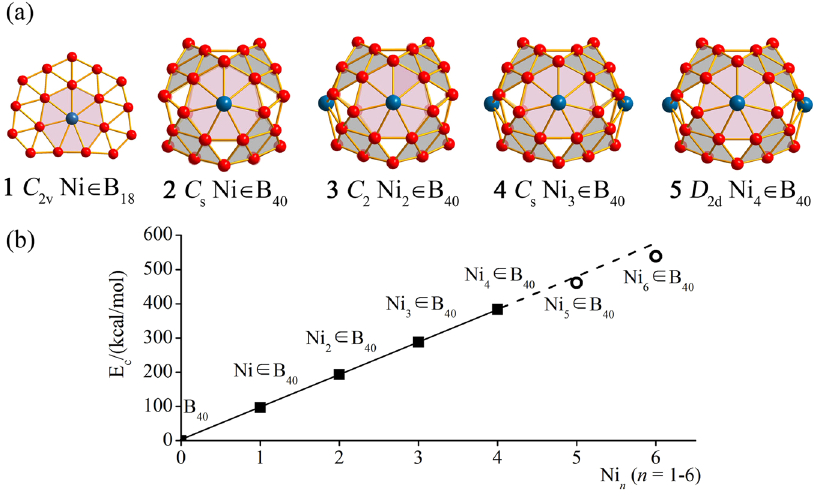
Figure 1. Optimized structures and calculated coordination energies. ( a ) Optimized structures of perfectly planar C 2v Ni ∈ B 18 ( 1 ) and cage-like C s Ni ∈ B 40 ( 2 ), C 2 Ni 2 ∈ B 18 ( 3 ), C s Ni 3 ∈ B 40 ( 4 ), and D 2d Ni 4 ∈ B 40 ( 5 ) at PBE0/6-311 + G * level. ( b ) Calculated coordination energies (E c ) of the Ni n ∈ B 40 heteroborospherenes with respect to Ni n B 40 = Ni (n-1) B 40 + Ni (n = 1–6).The optimized structures of the C 2v Ni 5 ∈ B 40 ( 8 ) and D 2d Ni 6 ∈ B 40 ( 9 ) are depicted in Fig.